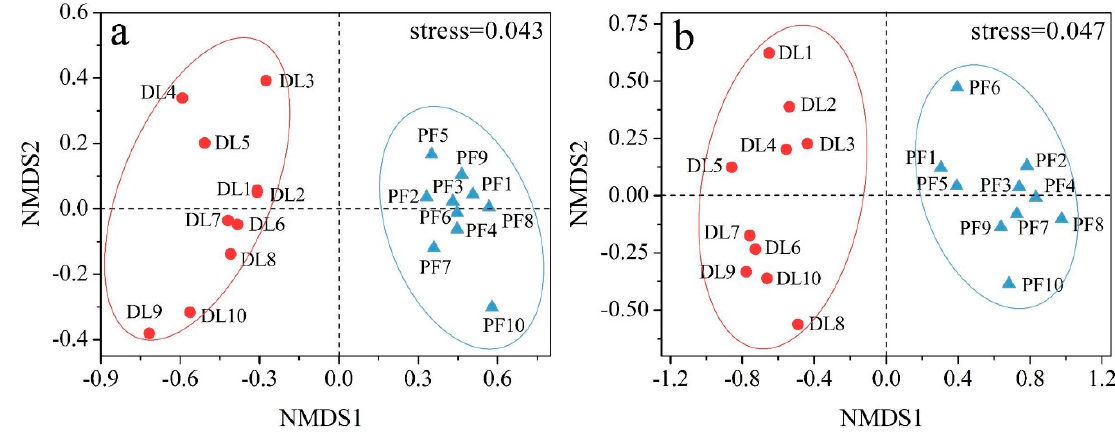
Figure 1. Alpha diversity indices of soil ( a ) bacteria and ( b ) fungi in different land use types. Note: DL is the soil sample of dry land before corn harvest, and PF is the soil sample of paddy field before rice harvest. The same for below.